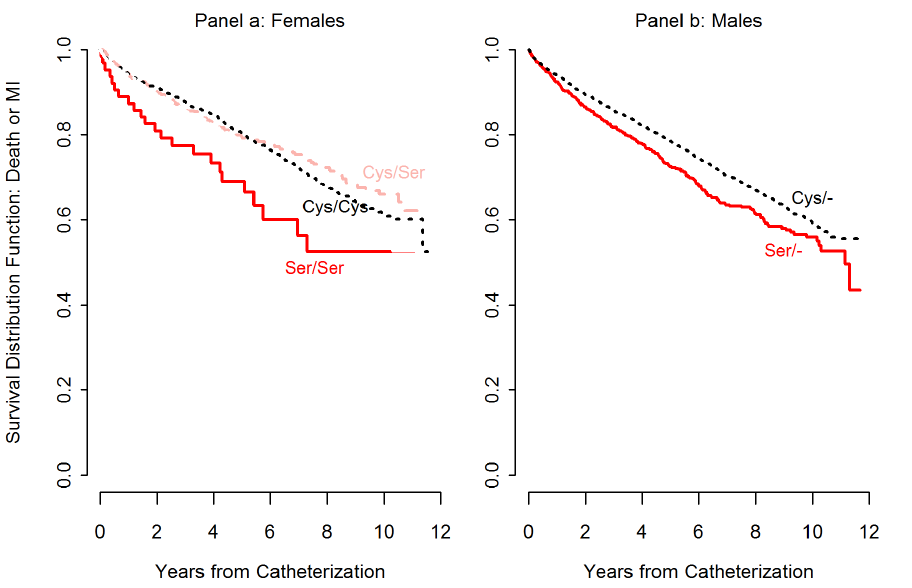
Figure 1. Kaplan-Meier curves illustrating the risk of death or myocardial infarction for each rs6318 genotype in Women (panel a) and Men (panel b). Using pre-specified contrasts in a Cox regression model adjusted for covariates, differences were statistically significant when comparing: male Ser23 C hemizygotes and female Ser23 C homozygotes to all Cys23 G carriers (p =.005); male Ser23 C hemizygotes to male Cys23 G hemizygotes (p =.022), and female Ser23 C homozygotes to female Cys23 G carriers (p =.024).